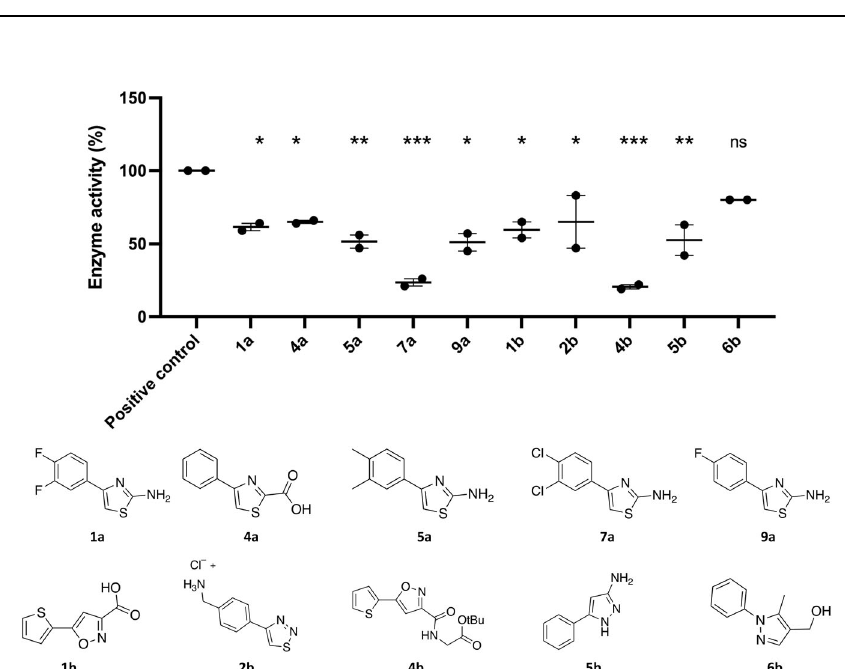
Fig. 4 Dot plot inhibition of the 4DT derivatives vs. control (DMSO). Data are represented as mean ± SEM; * p < 0.05, ** p < 0.01, *** p < 0.001 ( n = 2 biologically independent